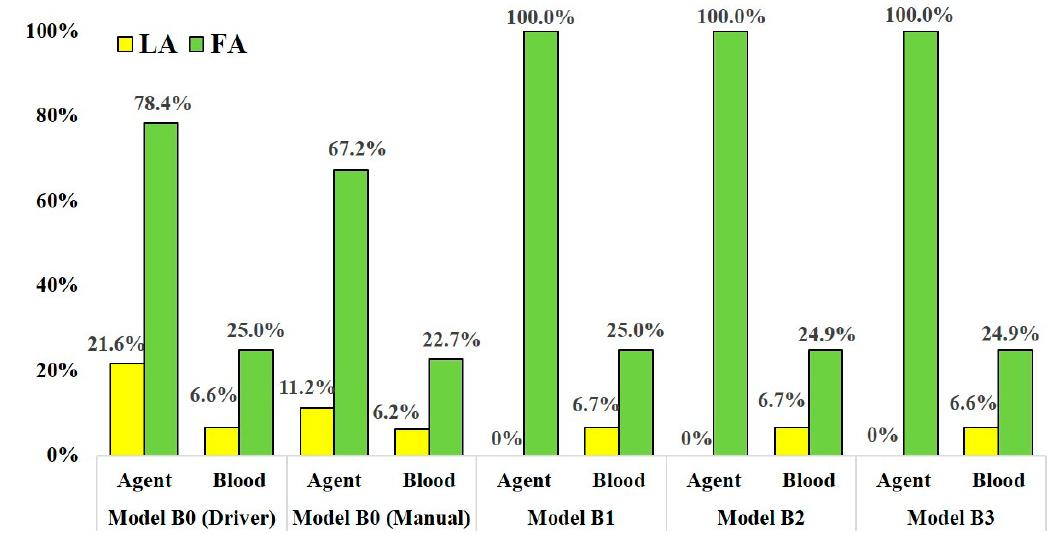
Figure 7. The distribution rate of anticancer agent and blood at the LA and FA in models